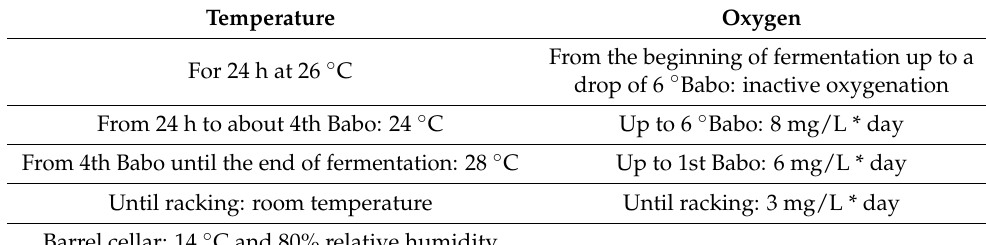
Table 2. Oxygenation and temperature protocol used. Temperature Oxygen From the beginning of fermentation up to a For 24 h at 26 ◦ C drop of 6 ◦ Babo: inactive oxygenation From 24 h to about 4th Babo: 24 ◦